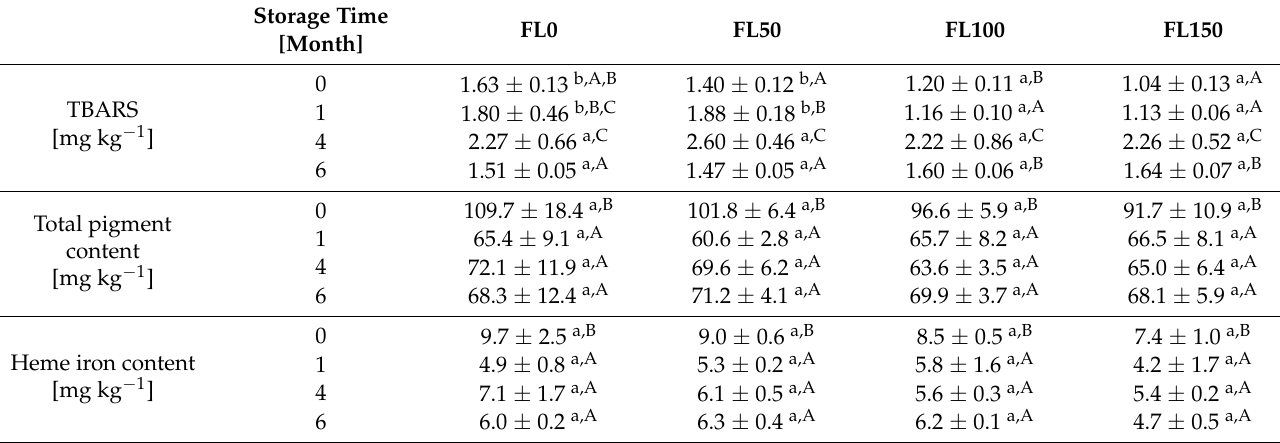
Table 5. TBARS, total pigment content and heme iron content in fermented loins during storage (mean ± standard